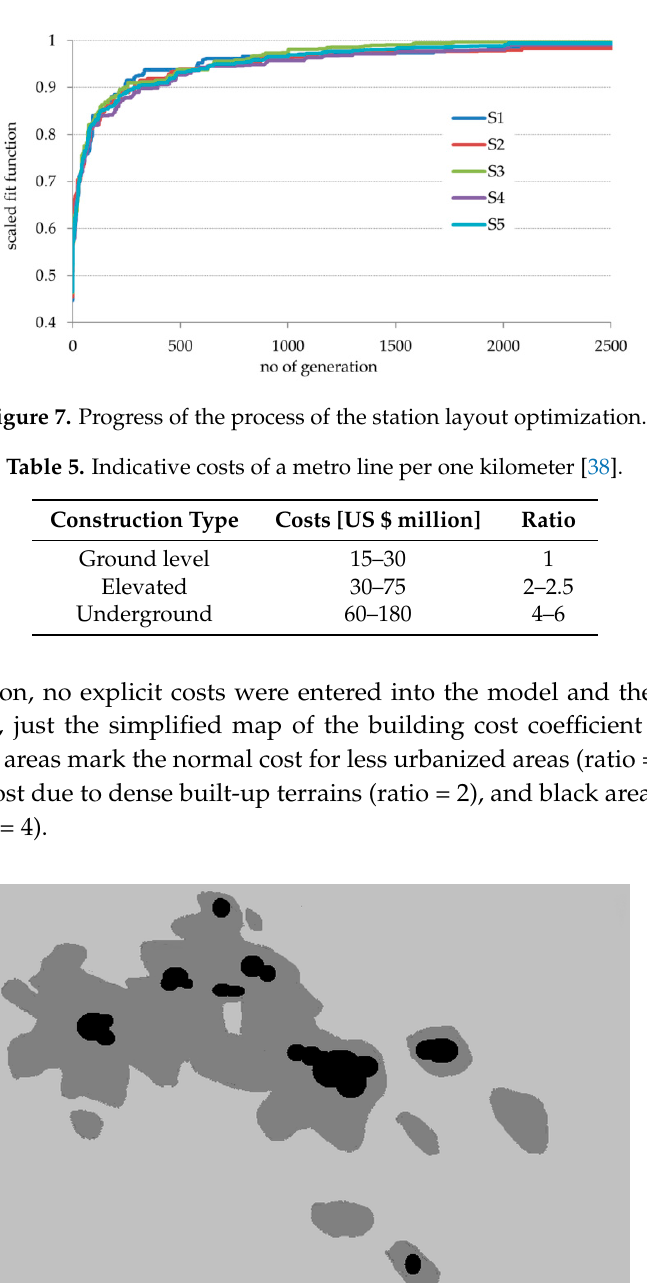
Table 6. Scheme of the optimization of lines topology.